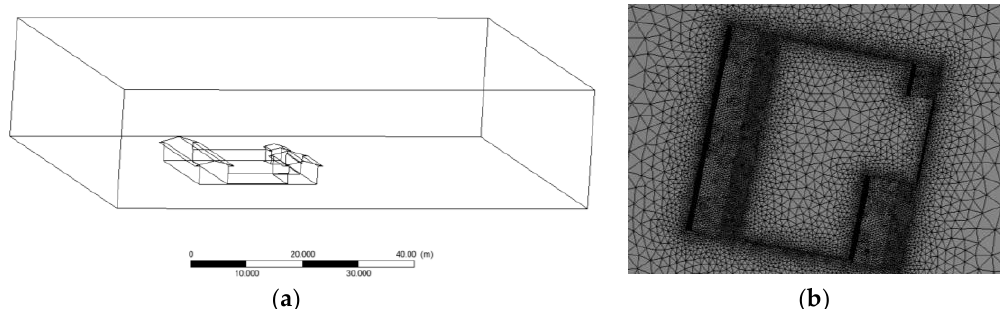
Figure 5. ( a ) Fluid domain and ( b ) meshes around the building in the simulation.